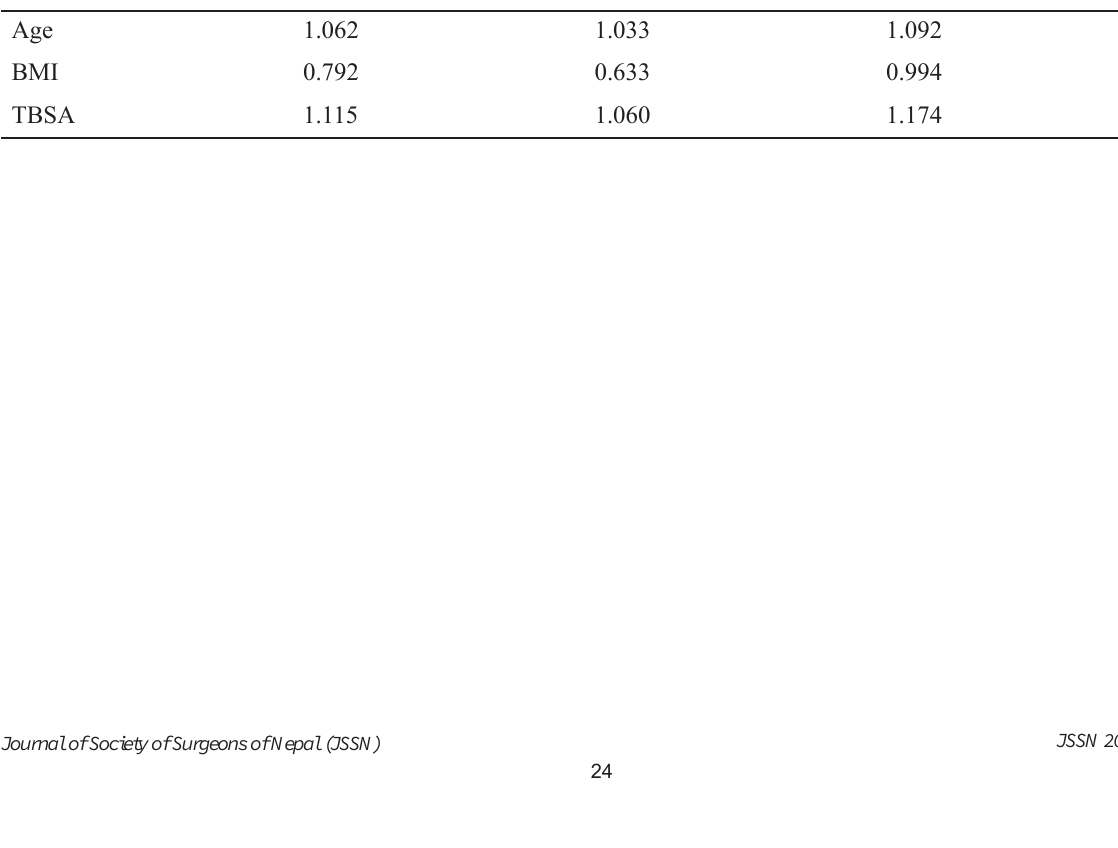
Table 3. Odds ratio estimate for burn mortalit y